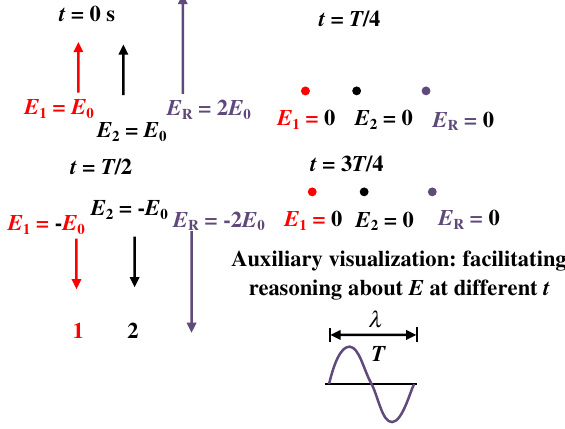
FIG. 3. SEV approach: Visualizing the processes that underlie the occurrence of maxima in double-slit